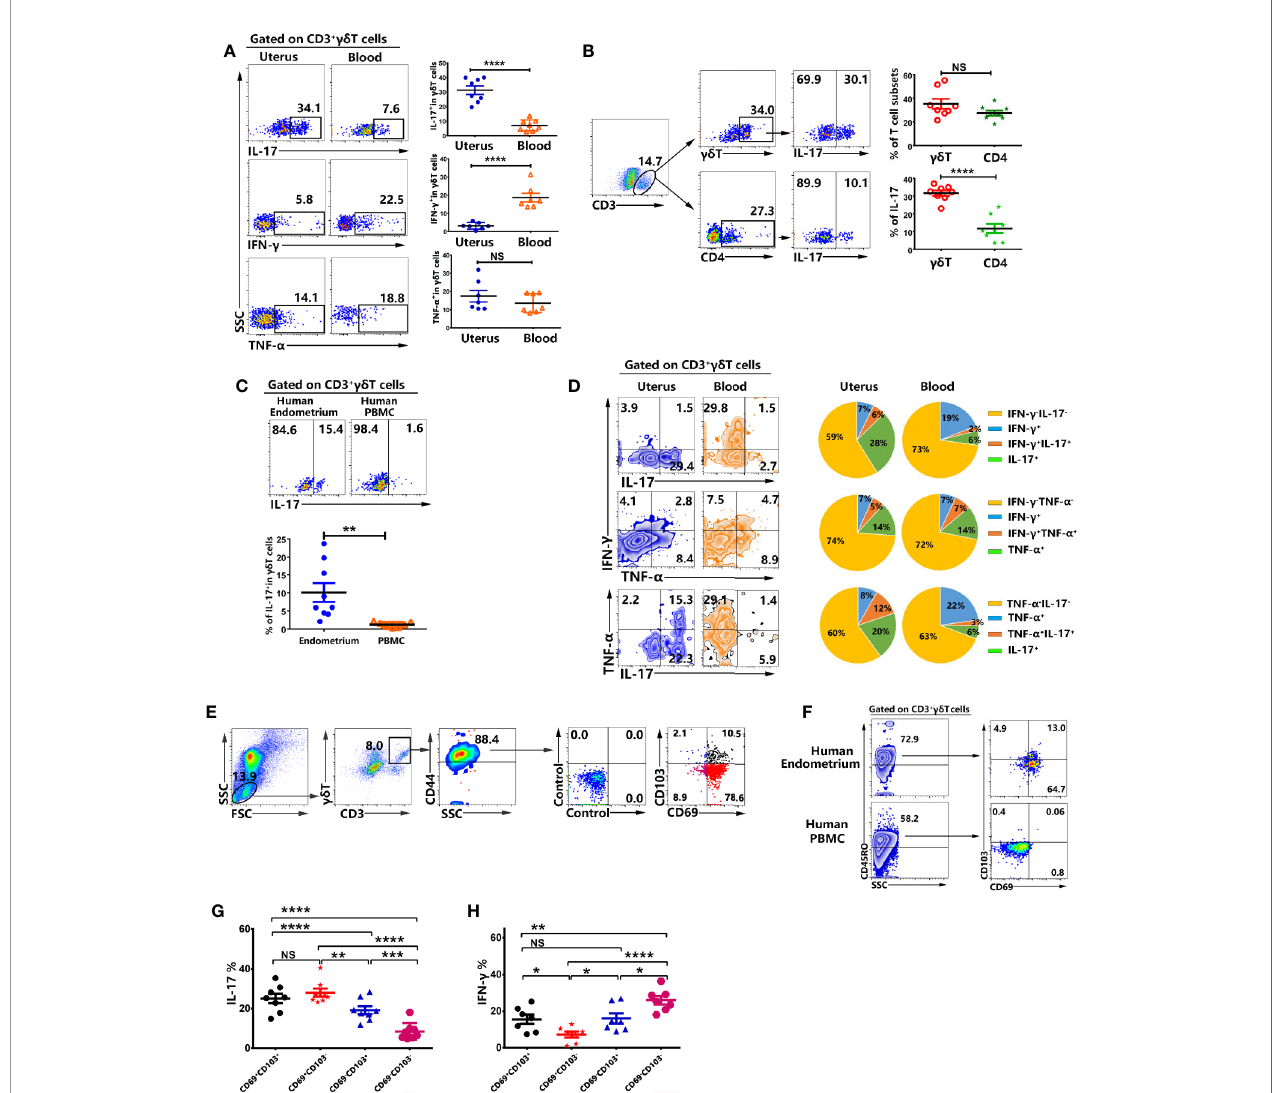
FIGURE 4 | Tissue resident memory gd T cells from uterus expressed high percentages of IL-17 but less expression of IFN- g . The mononuclear cells from uterus and blood were stimulated with or without PMA plus ionomycin in the presence of BFA for 6 h and analyzed by FACS. The representative graph and statistical results from 7-8 independent experiments with six mice in each experiment for the expression IL-17, IFN- g and TNF- a in gd T cells were shown (A) . The representative graph and statistical results for the expression of IL-17 in gd T and CD4 + T cells were shown (B) . The representative graph and statistical results for the expression of IL-17 in gd T cells from human endometrium and peripheral blood were shown (C) .The co-expression of IL-17, IFN- g and TNF- a was analyzed by FACS. The representative graph and pie chat (n=6) of IL-17, IFN- g and TNF- a single and co-expression were shown (D) . Gated on uterine CD3 + gd T + CD44 + cells, the representative graph of the expression of CD69 and CD103 were shown (E) . Gated on CD3 + gd T + cells, the representative graph of the expression of CD45RO, CD69, and CD103 in human endometrium and peripheral blood were shown (F) . The expression of IL-17 (G) and IFN- g (H) on CD69 + CD103 + , CD69 + CD103 − , CD69 − CD103 + , CD69 − CD103 − gd T cells from uterus was analyzed by FACS. The data were shown as mean ± SEM and statistical signi fi cance was determined with the Mann – Whitney U test. NS, no signi fi cance, *P < 0.05, **P < 0.01, ***P < 0.001 and ****P <